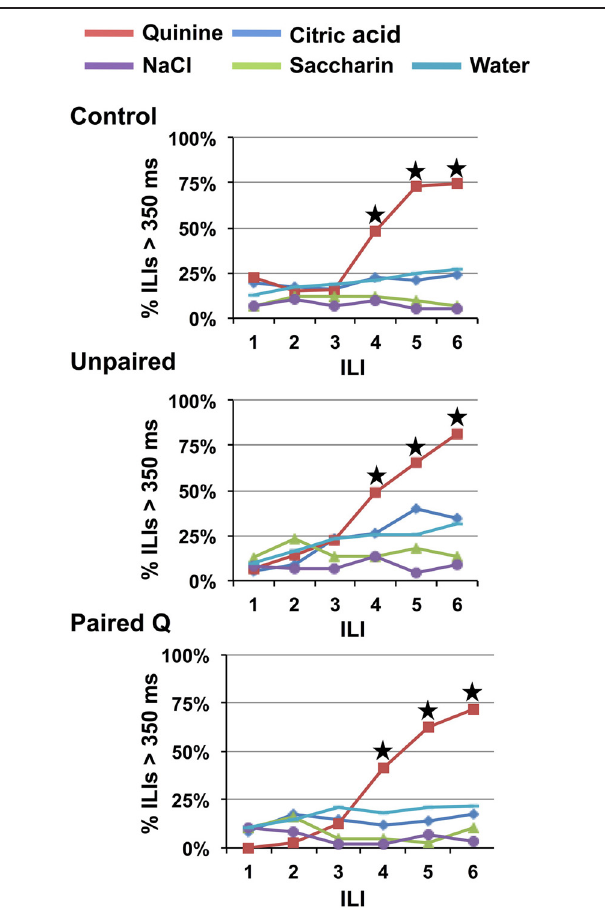
FIGURE 5 | Experiment 1B: high concentrations of quinine speeds identification across groups. Percentage of ILI’s above 350ms for Control, Unpaired, and Paired Q groups for all tastants. Quinine was presented at a high concentration (10mM). Stars indicate significant difference at p < 0 . 05. All groups identified quinine at